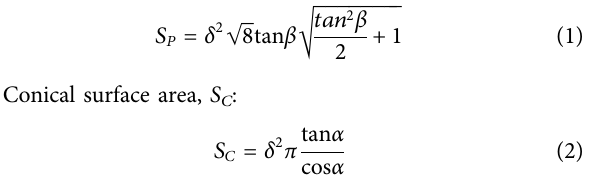
Frontiers in Physics |